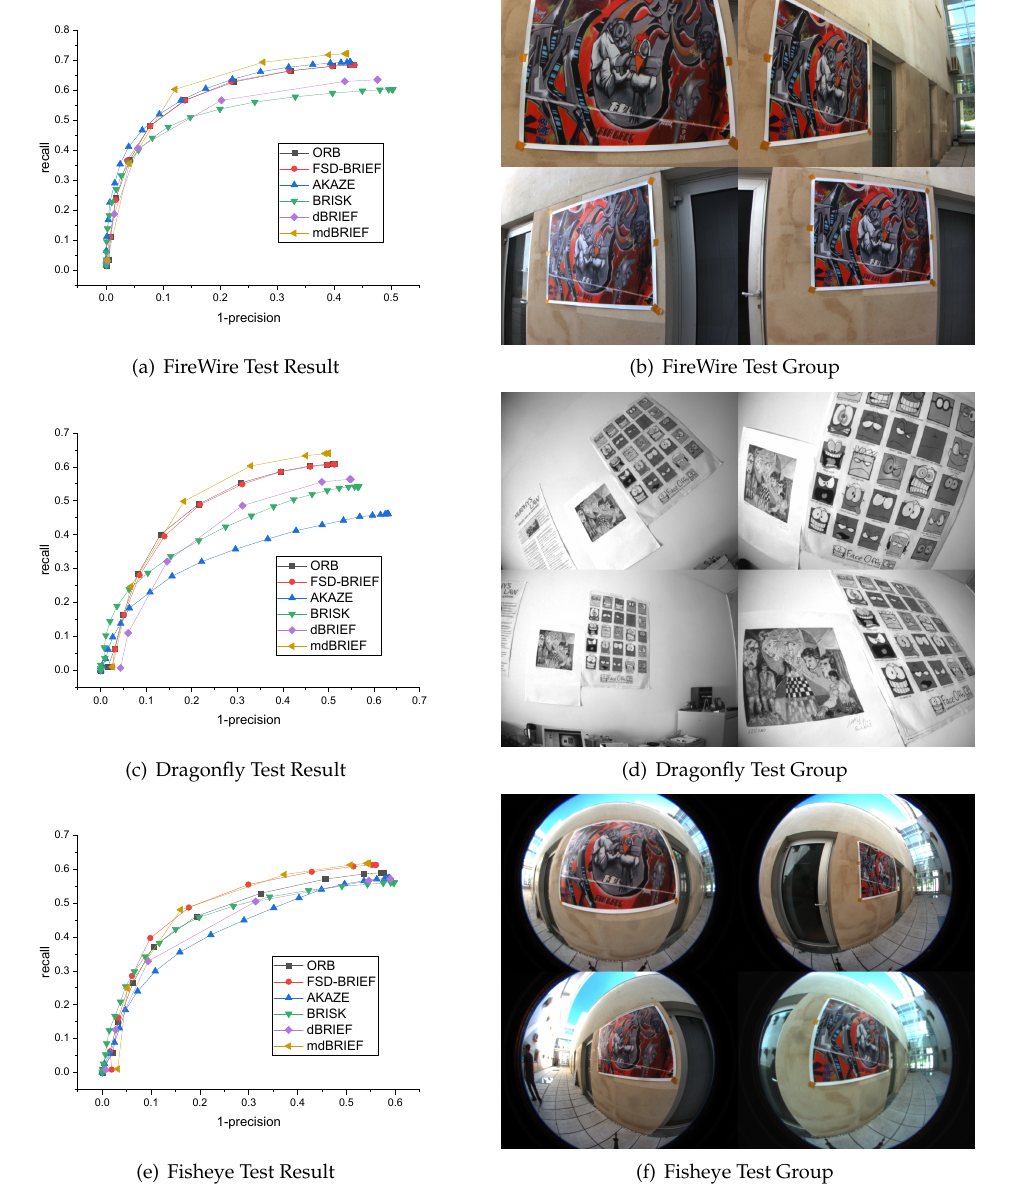
Figure 14. sRD-SIFT dataset and corresponding PR curve